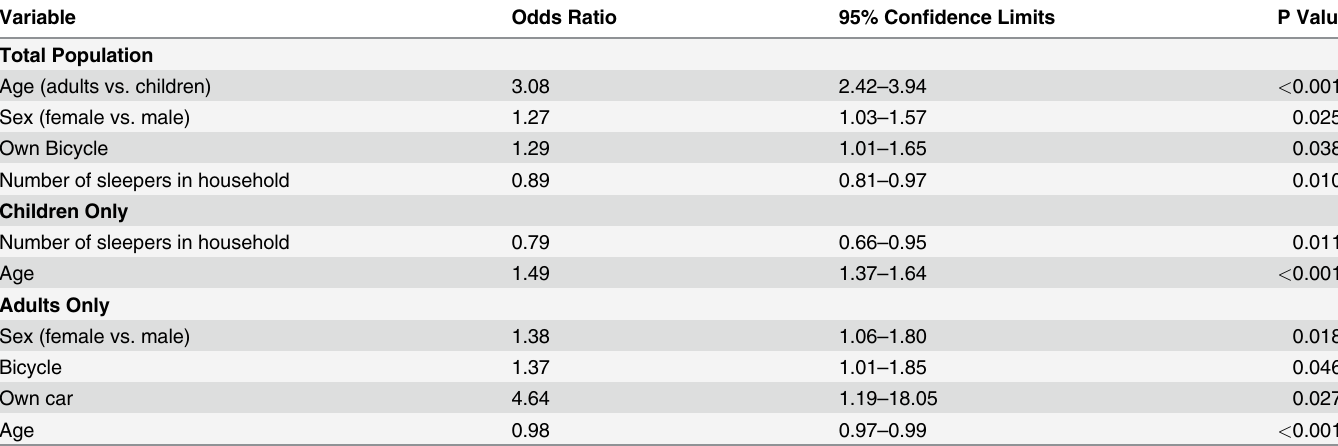
Table 1. Bivariate analysis of factors associated with alphaviral seropositivity controlling for village of residence. Variable